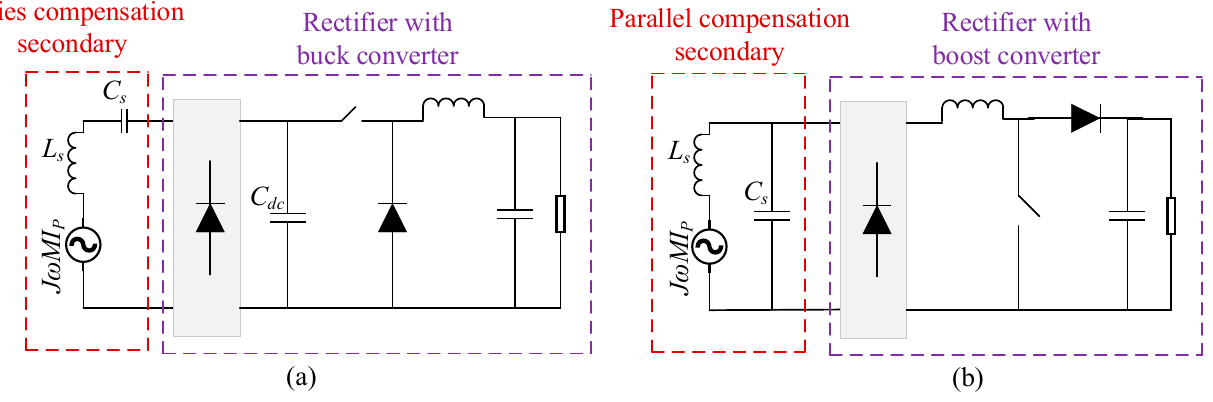
Figure 21. Types of receiver-side converter: ( a ) buck converter for series compensated receiver and ( b ) boost converter for parallel compensated receiver.